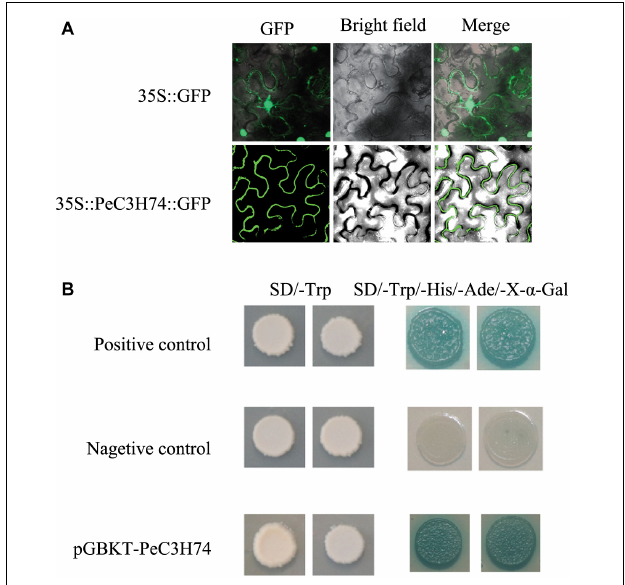
FIGURE 5 | Subcellular localization of PeC3H74 and transactivational analyses of PeC3H proteins in yeast Y2HGold strain. (A) The PeC3H74-GFP fusion proteins and GFP as a control were transiently expressed in N. tabacum leaves and observed under a fluorescence microscope. (B) The positive constructs, negative constructs, and fusion constructs were transformed into yeast Y2HGold strain and successively incubated in SD/–Trp media and SD–His/–Ade/–Trp plate supplemented with X - α